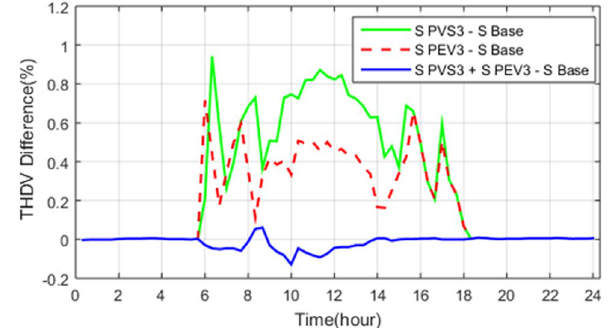
Figure 14. Analysis of daily pro fi les of THD when zero medium voltage grid and PEV harmonic.